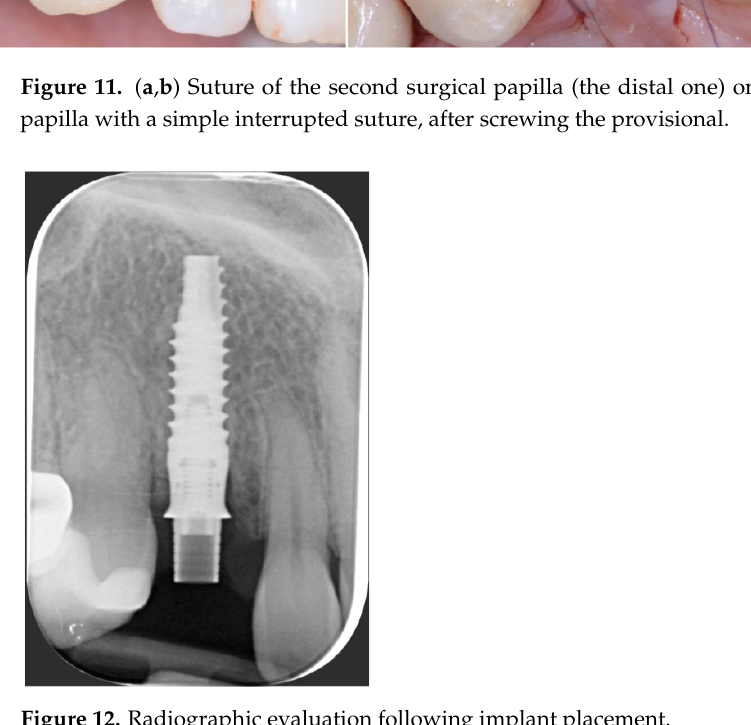
Figure 12. Radiographic evaluation following implant placement.